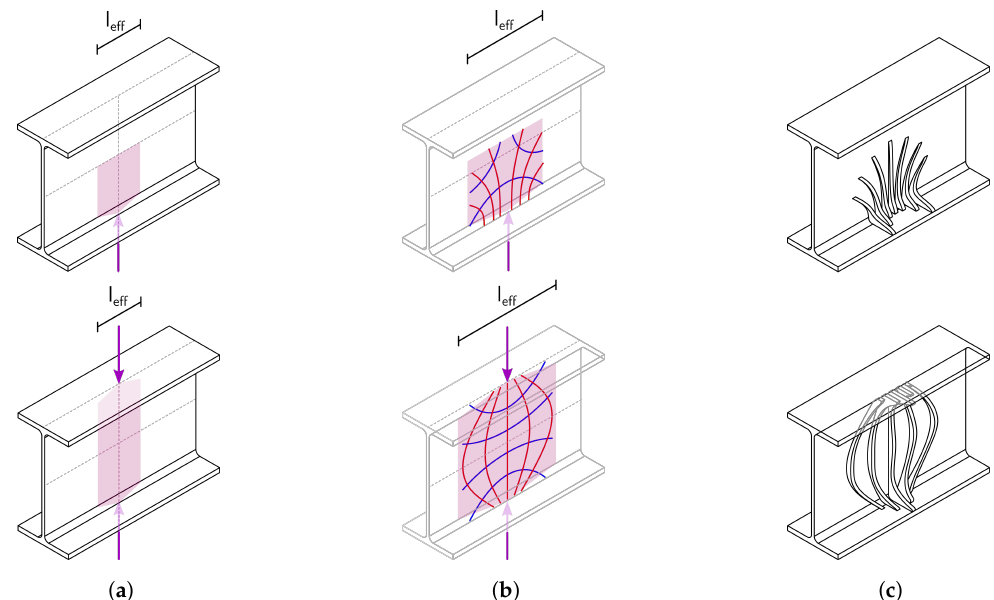
Figure 10. Design approach—optimized load application: ( a ) standard effective length; ( b ) theoreti- cally possible length; ( c ) correspondingly strengthened web.